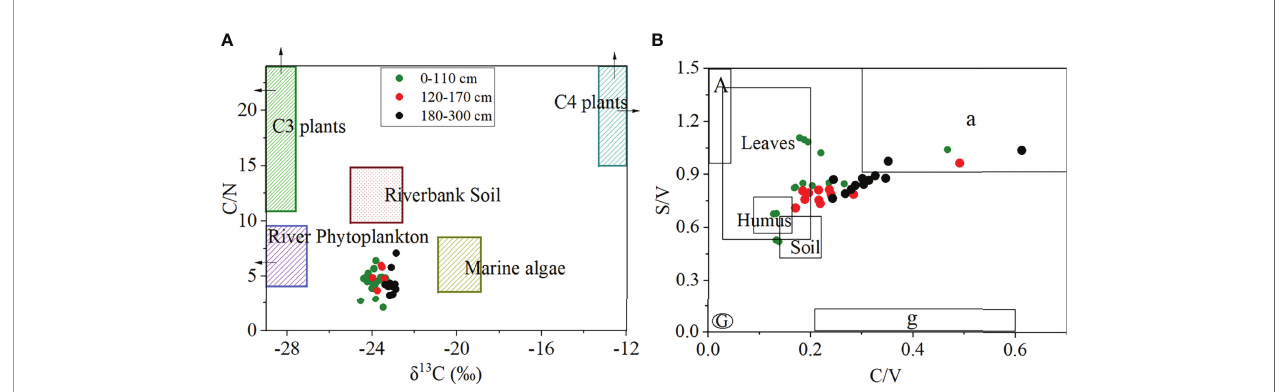
FIGURE 6 | Source plot of the sedimentary OC in the PRE based on (A) d 13 C and C/N; (B) C/V and S/V. G=woody gymnosperm, g=nonwoody gymnosperm, A=woody angiosperm and